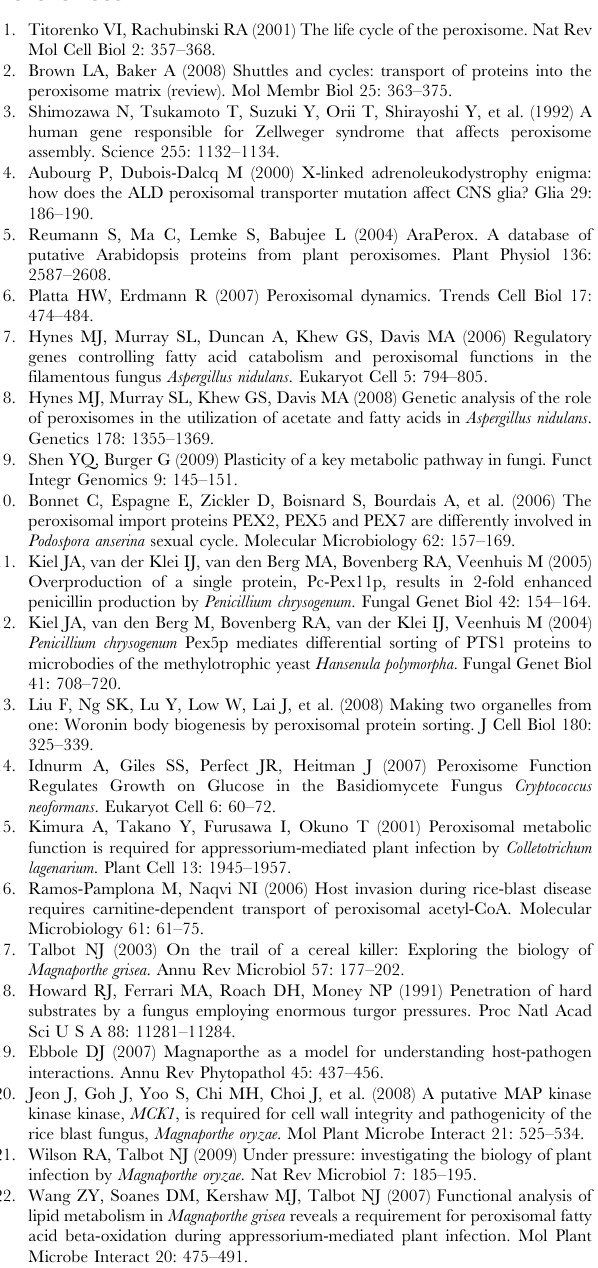
Table S1 List of putative peroxins in M. oryzae . Table S2 List of putative PTS2 cargo proteins in M. oryzae